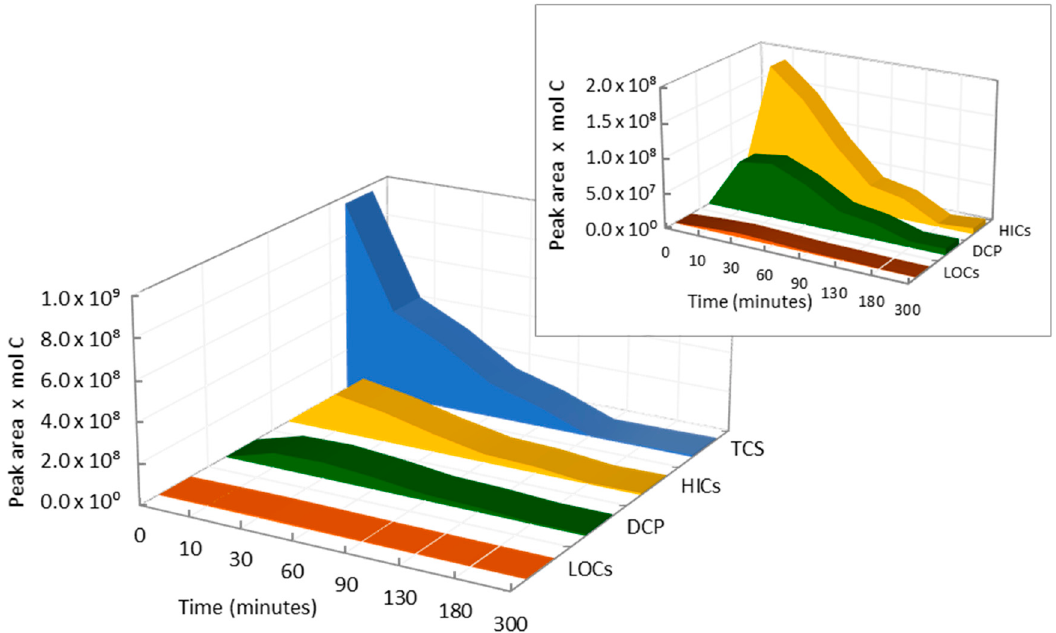
Figure 5. Disappearance of the parent TCS and formation of intermediate derivatives throughout the photocatalytic experiments.